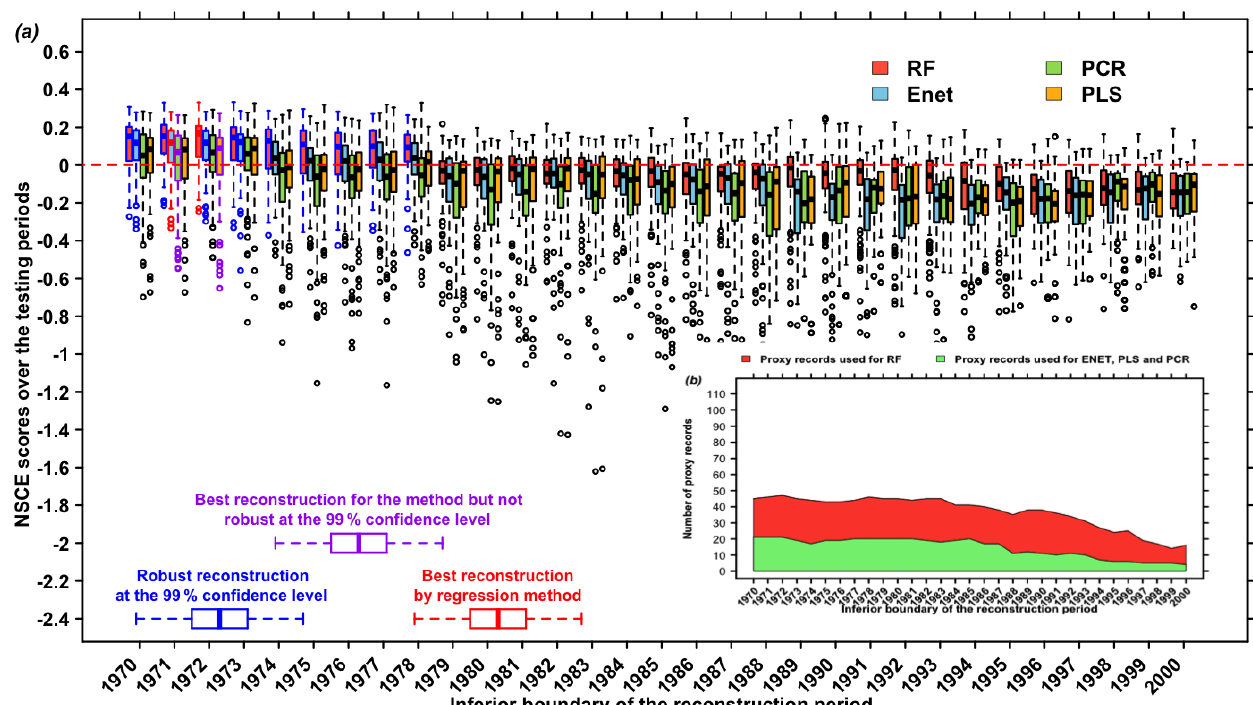
Figure 6. (a) Reconstructions are performed using 31 reconstruction periods for the four methods: from 1000–1970 to 1000–2000 by moving the most recent year by 1 with R = 50 training/testing samples. RF reconstructions are performed using the proxy records significantly correlated at the 80% confidence level with the NAO over the training periods (Sect. 3.1.1). PCR reconstructions are performed by selecting the proxy records significantly correlated at the 95% confidence level with the NAO over the training periods (Sect. 3.1.1). PLS and Enet reconstructions are performed by selecting the proxy records significantly correlated at the 95% confidence level with the NAO over the training periods (Sect. 3.1.1). (a) Red boxplots are the NSCE scores obtained using the RF method. Blue boxplots are the NSCE scores obtained using the Enet method. Red green are the NSCE scores obtained using the PCR method. Yellow boxplots are the NSCE scores obtained using the PLS method. Boxplots with blue edges are the significantly positive scores at the 99% confidence level. Boxplots with red edges correspond to the scores associated with the best reconstruction for each method. (b) Proxy records available/used by reconstruction period. The red area shows the number of records used for RF. The green area shows number of records used for Enet, PCR and PLS for each reconstruction